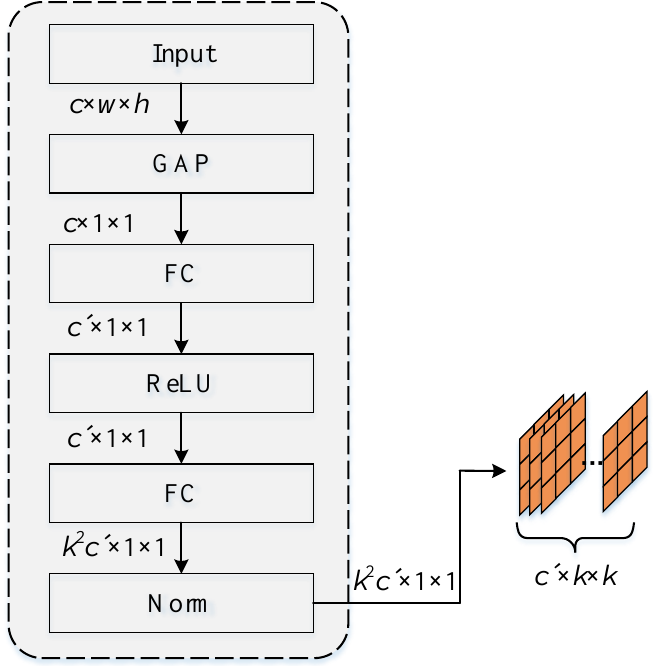
Figure 2. The kernel generates the module network structure, where GAP, FC, ReLU, and Norm denote the global average pooling layer, the fully connected layer, the activation function layer, and the normalization layer,